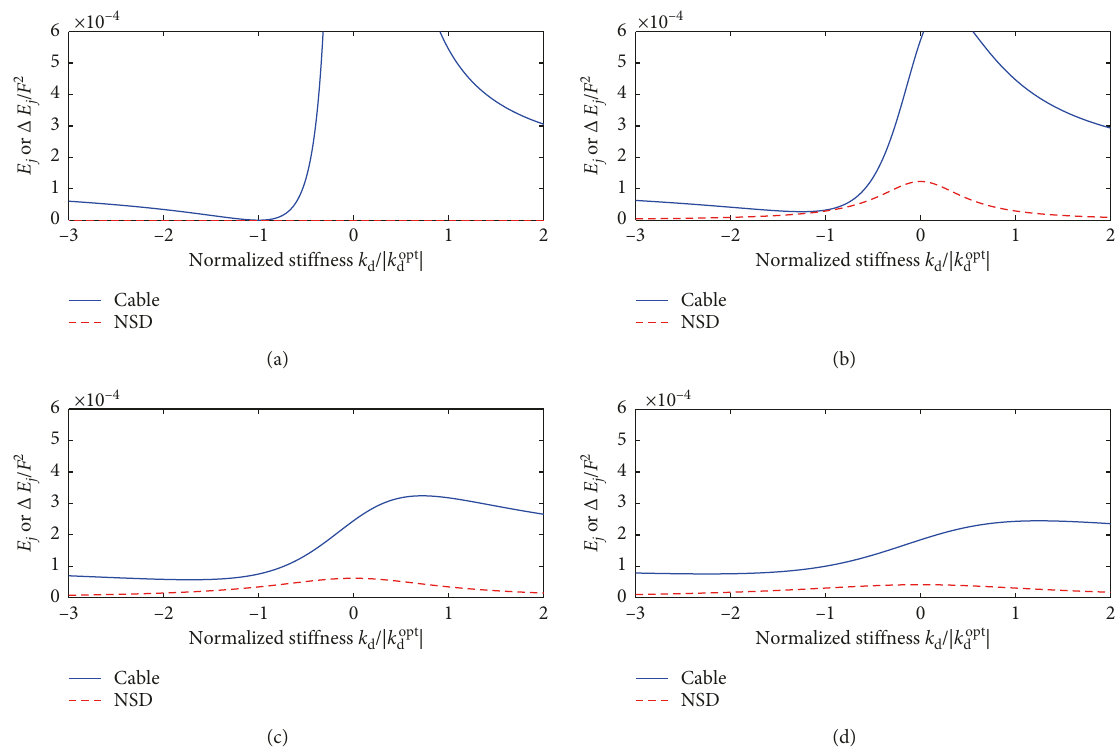
Figure 14: Change trend of the cable mechanical energy or the energy dissipated by the NSD to the stiffness with different levels of damping: ω � 0; (b) c ω � 10 N/mm; (c) c ω � 20 N/mm; (d) c ω � 30 N/mm. (a) c d d d d